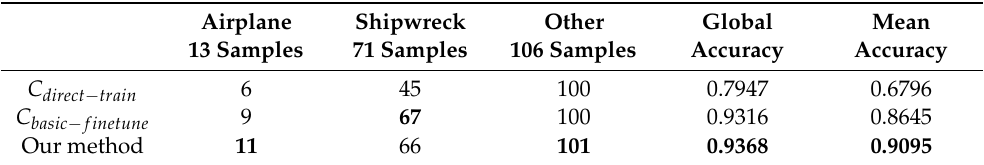
Table 1. Accuracy and total correct classifications (the number of test samples is also shown. We regard only true positives as correct, and the best results are marked in